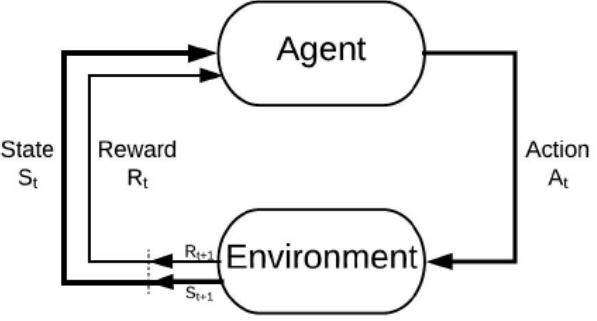
Figure 1. The reinforcement learning problem.